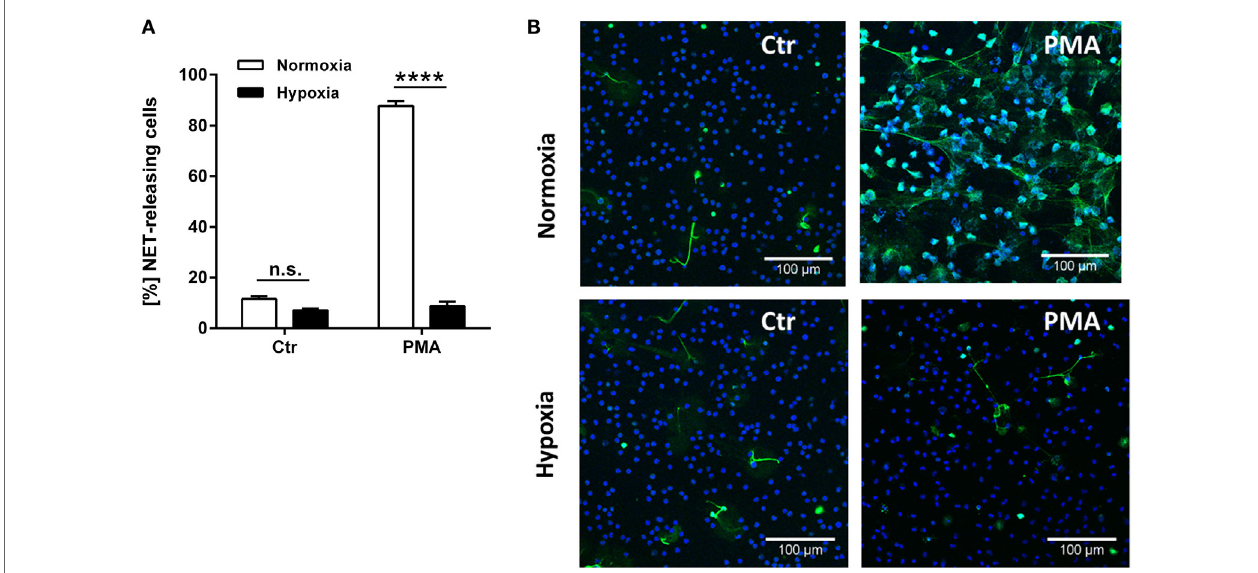
FiGUre 2 | spontaneous and pMa-induced net-release is decreased under hypoxia . Neutrophils were incubated for 2 h under normoxia or hypoxia before treatment with 25 nM PMA for additional 3 h. Formation of NETs was visualized using a monoclonal antibody against histone–DNA complexes (green) in combination with DAPI to stain the nuclei (blue). (a) Under normoxia NET-release was stimulated with PMA in 87.7 ± 1.8% of the cells, while 11.6 ± 1.0% of the neutrophils formed NETs spontaneously. Incubation under hypoxia decreased the spontaneous NET-release to 7.1 ± 0.7% and abrogates the PMA-stimulatory effect to a rate of 8.8 ± 1.7%. (B) Representative fluorescence micrographs depicting NET-release of neutrophils. Statistical analysis of was performed with one-tailed paired Student’s t -test.